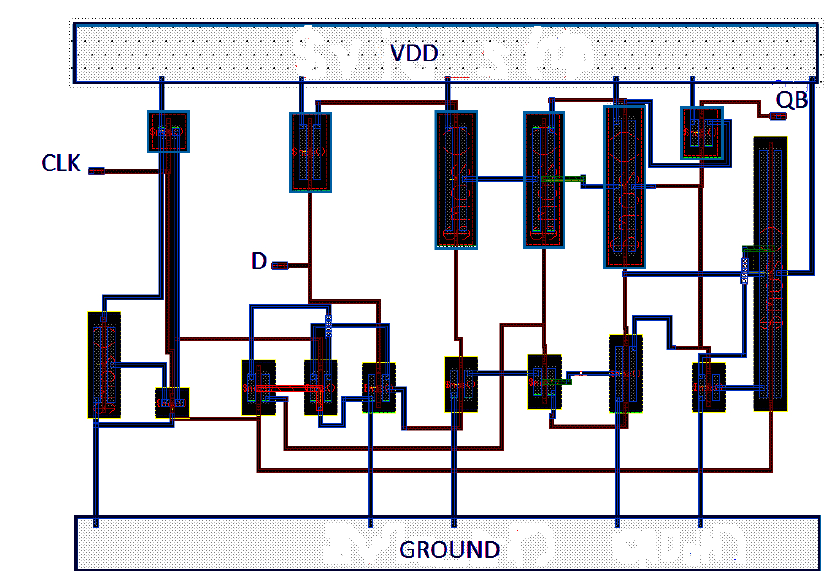
Figure 11. Minimum delay of the proposed FF. Electronics 2016 , 5 , 92